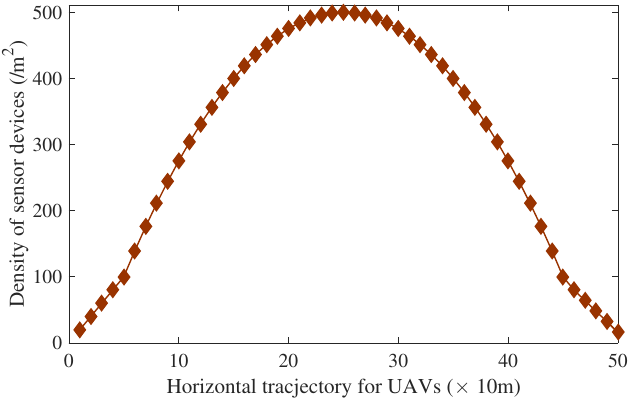
Figure 7. Density distribution of sensor devices in this